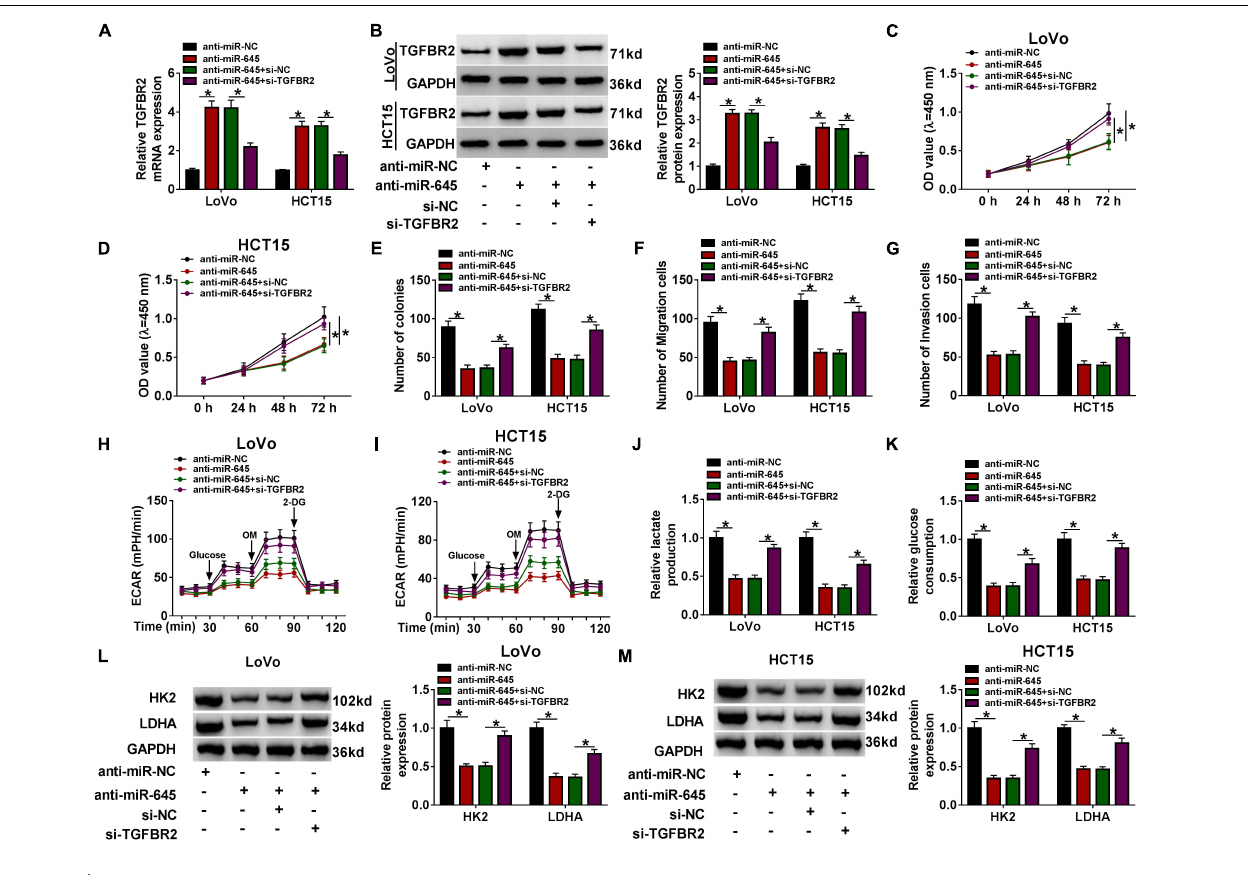
FIGURE 6 | miR-645 promoted CRC progression in vitro by mediating TGFBR2. LoVo and HCT15 cells were transfected with anti-miR-645 or anti-miR-645 + si-TGFBR2, with anti-miR-NC or anti-miR-645 + si-NC as the corresponding control. (A,B) The expression of TGFBR2 was examined using qRT-PCR and western blot. (C–E) Cell proliferation was investigated using CCK-8 assay and colony formation assay. (F,G) Cell migration and invasion were monitored by transwell assay (magnification: 100 × ). (H,I) ECAR was measured by glycolysis stress test. (J,K) Lactate production and glucose consumption were detected using the corresponding kits. (L,M) The expression of HK2 and LDHA was measured by western blot. * P <